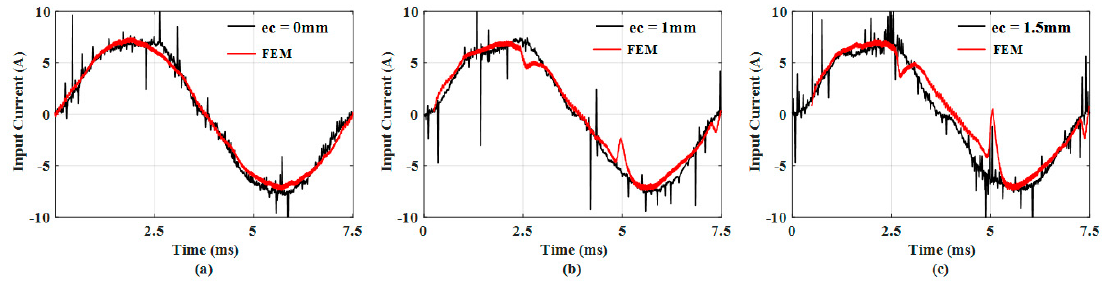
Figure 7. Experimental results of input current: ( a ) ec = 0 mm, ( b ) ec = 1 mm, and ( c ) ec = 1.5 mm.